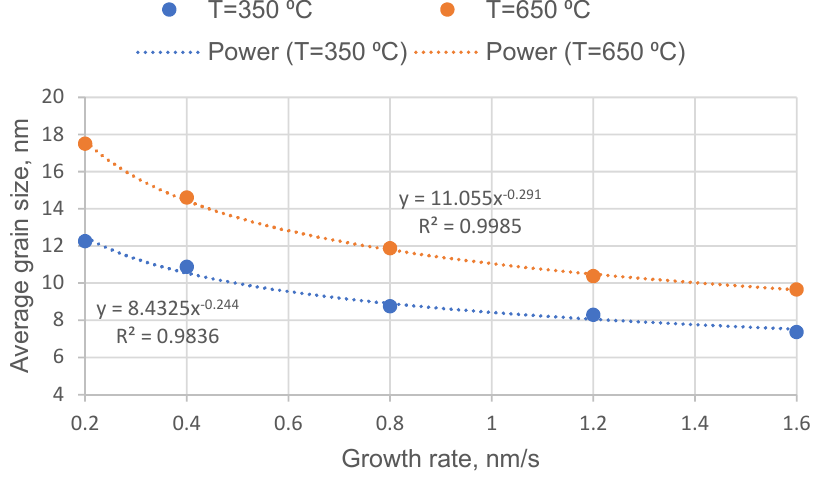
Figure 12. Plots of average grain size versus growth rate observed at the substrate temperatures of 350 °C and 650 °C.